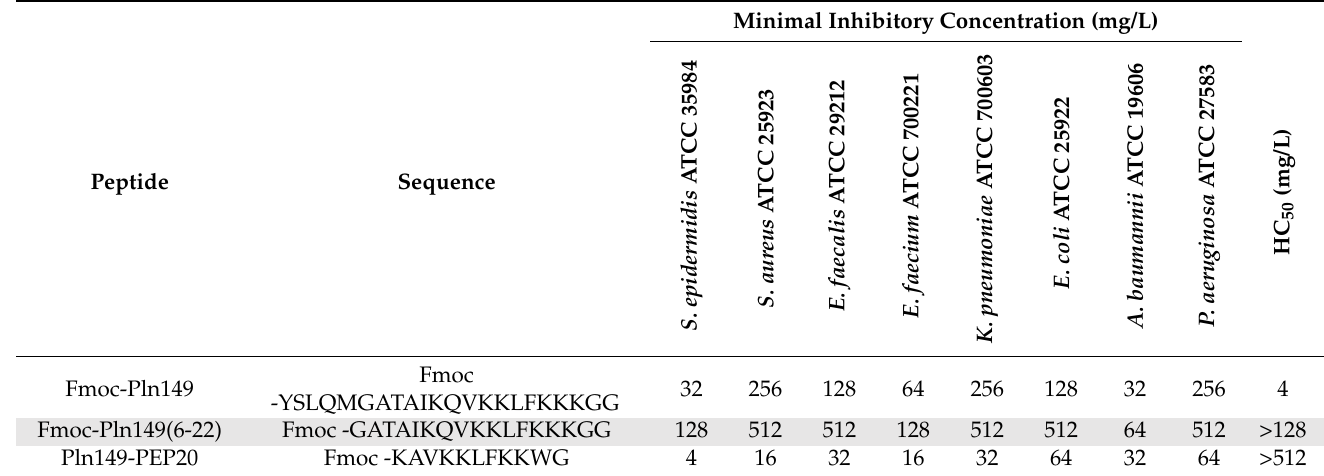
Table 1. Antimicrobial and hemolytic activity of Plantaricin 149